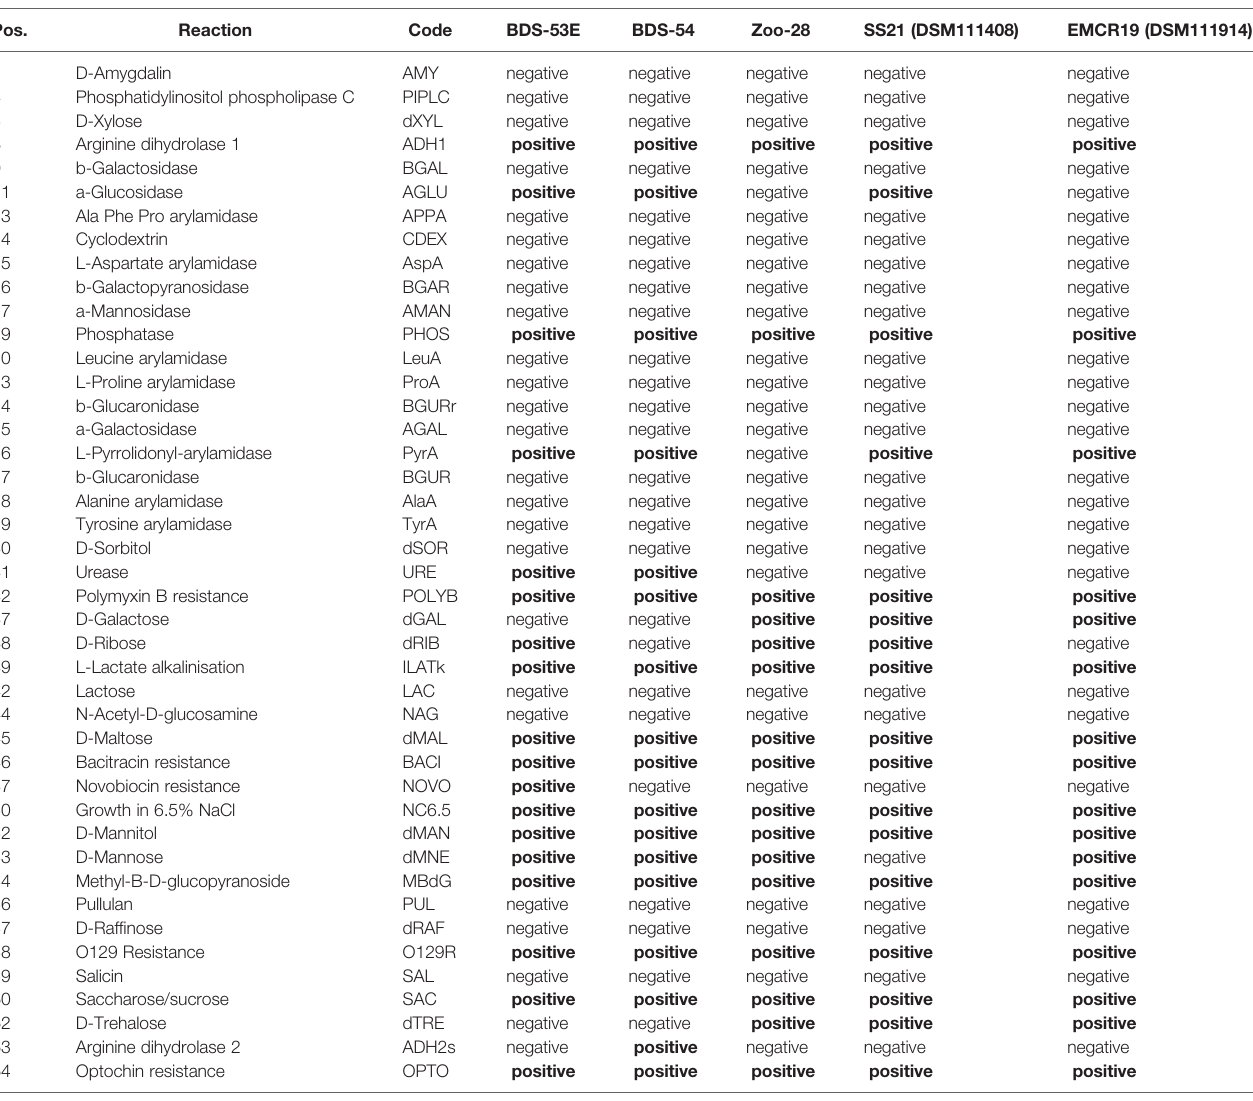
TABLE 2 | Biochemical pro fi les, based on results for bioMe ́ rieux´ Gram-positive identi fi cation card (GP) for VITEK-2.